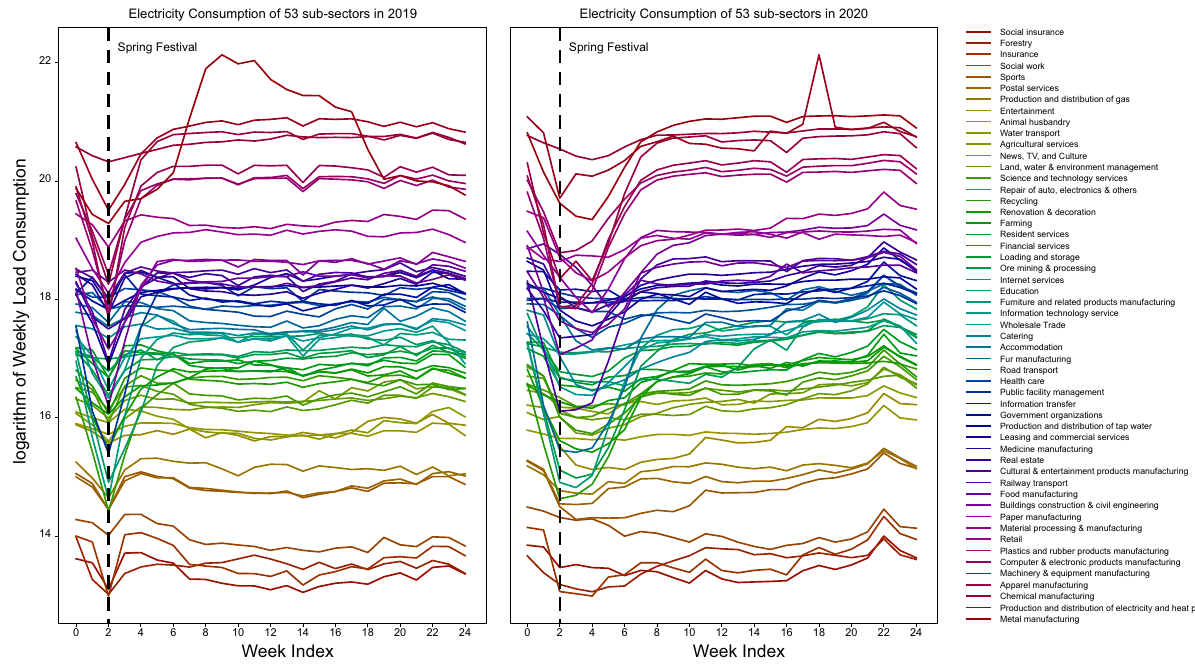
Figure 3. Weekly electricity consumption of 53 sub-sectors in 2019 and 2020: each line represents the logarithm of the electricity consumption of one sub-sector.The vertical dashed line represents the week of the Spring Festival